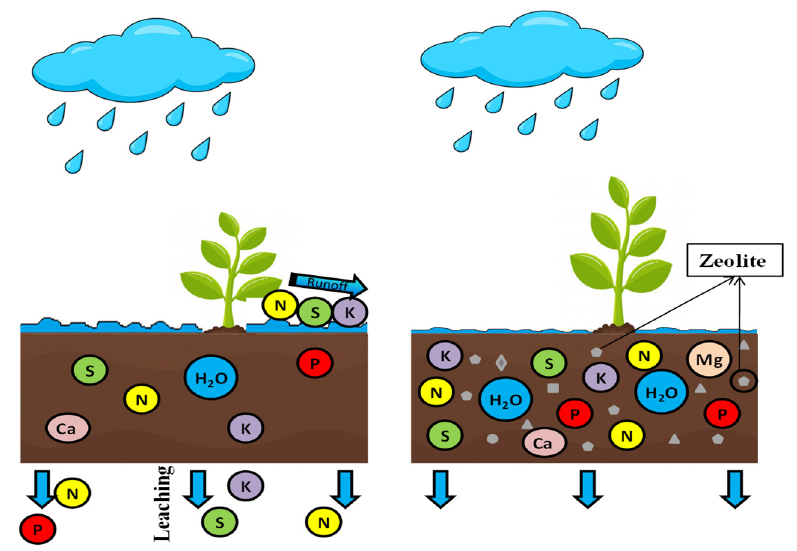
Figure 10. Effectiveness of Zeolite on Water and Nutrient Retention in Soil. Modified from Nakhli et al. (2014).